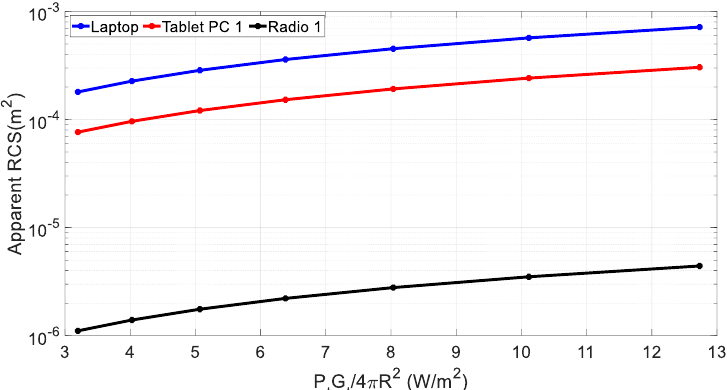
Figure 5. Measured apparent RCS of targets vs. the incident power density.